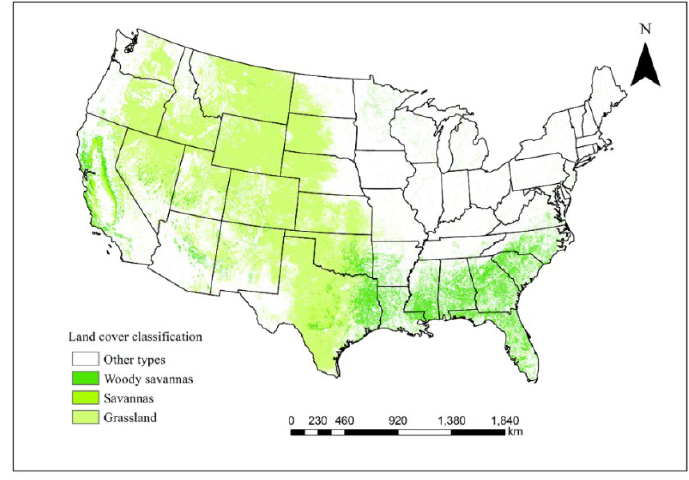
Figure 4. The grassland distribution for the contiguous